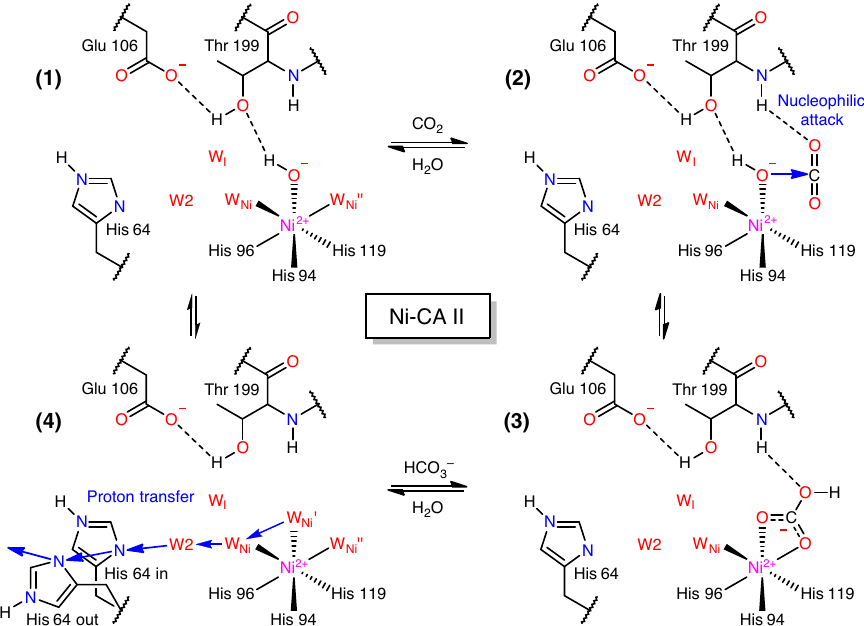
Fig. 8 Proposed catalytic mechanism of Ni-CA II. In Ni-CA II, octahedral coordination is maintained throughout the whole catalytic cycle. The signi fi cant consequence is that one of the three bound water molecules experiences steric hindrance with the CO 2 binding. In addition, the nucleophilic attack geometry is distorted (Fig. 5b), suggesting less ef fi cient conversion into HCO 3 − . The formed HCO 3 − is strongly bound to Ni 2 + ion in a bidentate mode as in the Co-CA II but is directly displaced by two in fl owing water molecules. Finally, proton transfer occurs via an altered network (possibly, W Ni ′ → W Ni → W2 → His64) to restore the catalytic cycle.